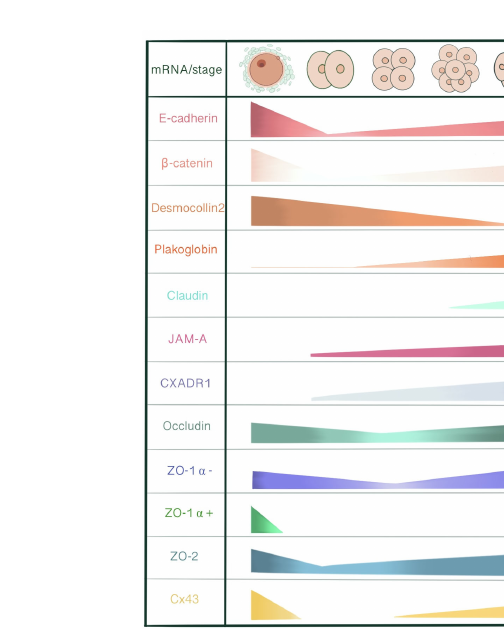
Four PKC isoforms ( q , d , i / l , z ) demonstrate co-localization with ZO-1 a + in apical membranes of TE, whereas remain in the cytoplasm ofICMandactivelyregulateblastocoelformationandTEdifferentiation (144).TJproteinsaredifferentiallyregulatedbyPKCisotypes.Inisolated ICM, indolactam- and TPA- mediated PKC activation stimulates